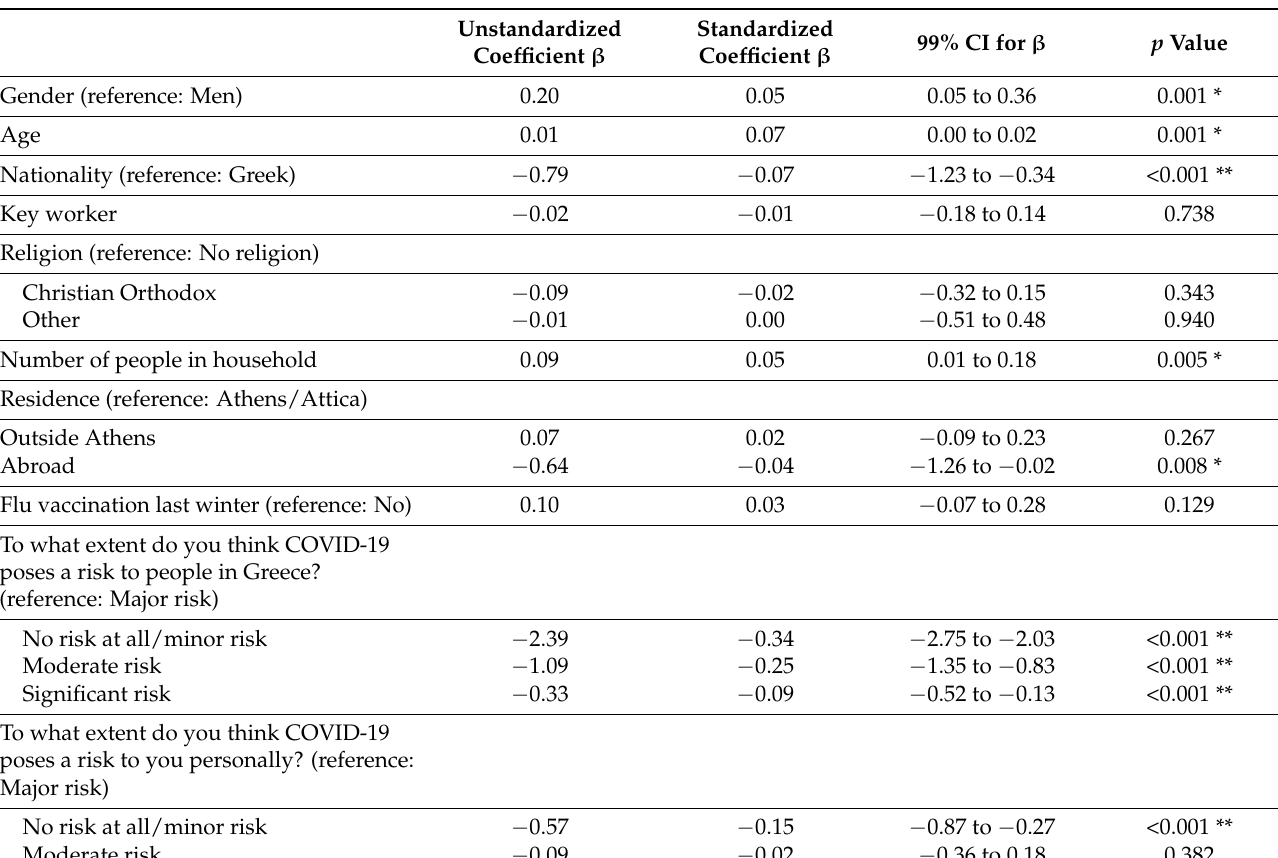
Table 4. Multiple regression analysis results with number of behavioral changes due to the COVID- 19 pandemic as dependent variable, and participants’ characteristics and their perceptions of the COVID-19 pandemic as independent variables. Note. The model was based on 2863 cases with complete data. * p < 0.01; ** p <